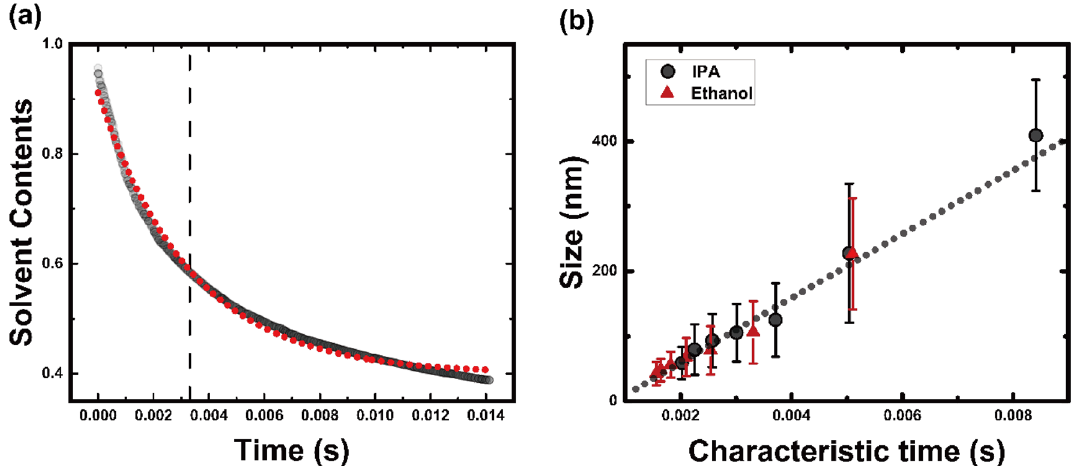
Figure 3. ( a ) Exponential fitting of the ethanol content. Red dots represent an exponentially fitted curve and dashed line indicates the decay constant. ( b ) Relationship between liposome size and characteristic time of self-assembly. Black dotted line represents a linear curve fitted using the least-squares method ( R red and black circles are experimental results for ethanol and IPA, respectively. Characteristic time was obtained from the decay constant of the exponentially fitted curve for the Lagrangian content of the